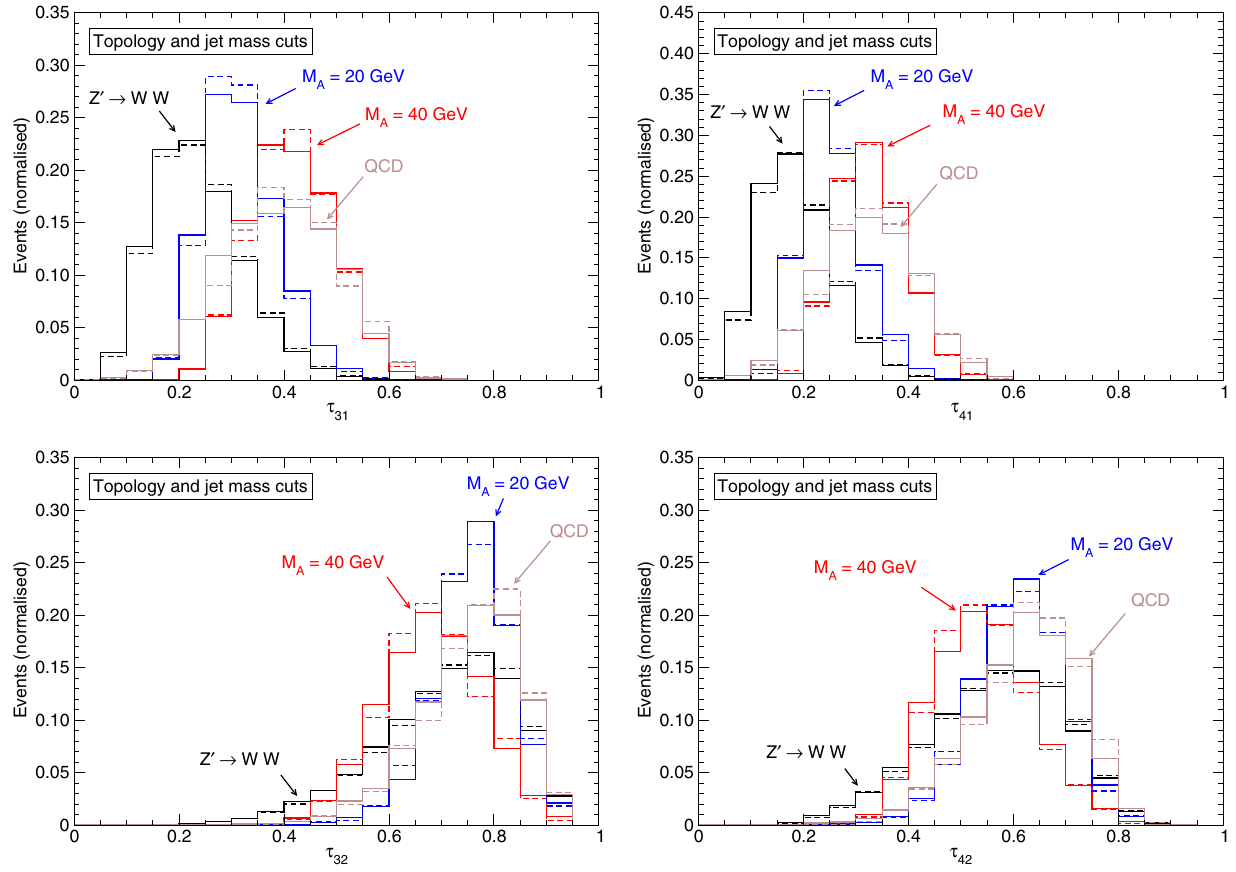
Fig. 14 Higher-order N -subjettiness ratios τ nm = τ n /τ m for R → SS and Z (cid:8) → WW signals and the QCD dijet background. Solid (dashed) lines correspond to the leading (subleading)